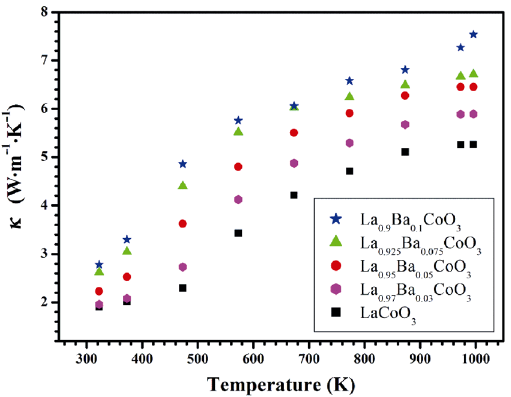
Fig. 7 Temperature dependence of κ of the La 1 − x Ba x CoO 3 sample with x = 0, 0.03, 0.05, 0.075, and 0.1.